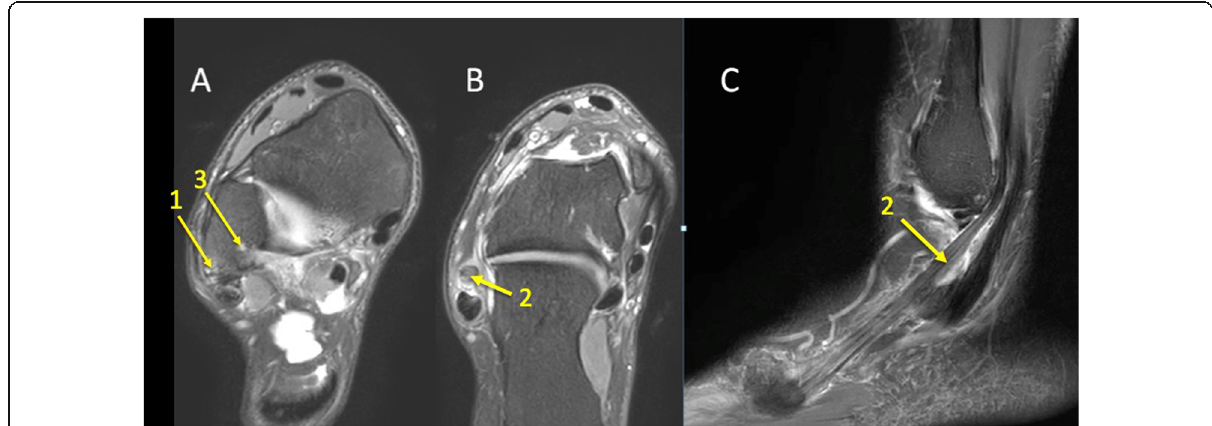
Fig. 9 A 59-year-old female with 10-month history of lateral ankle pain and suspicion of an osteochondral lesion. MRI showed tendinopathy of the peroneus brevis tendon. (1) BME in the fibula adjacent to (2) the tendinopathy of the peroneus brevis tendon. (3) A traction cyst at the